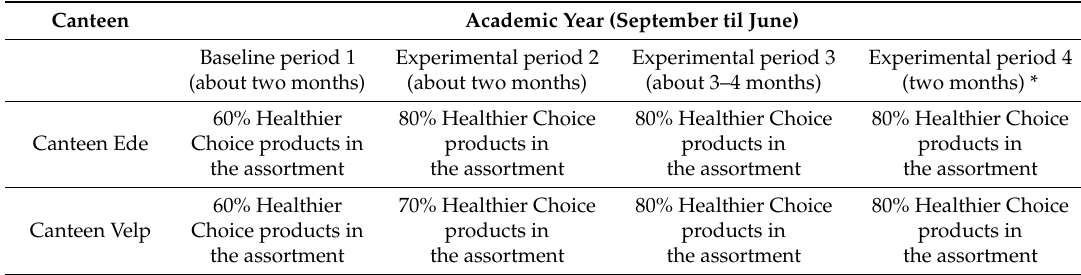
Table 1. Experimental design of the study in two